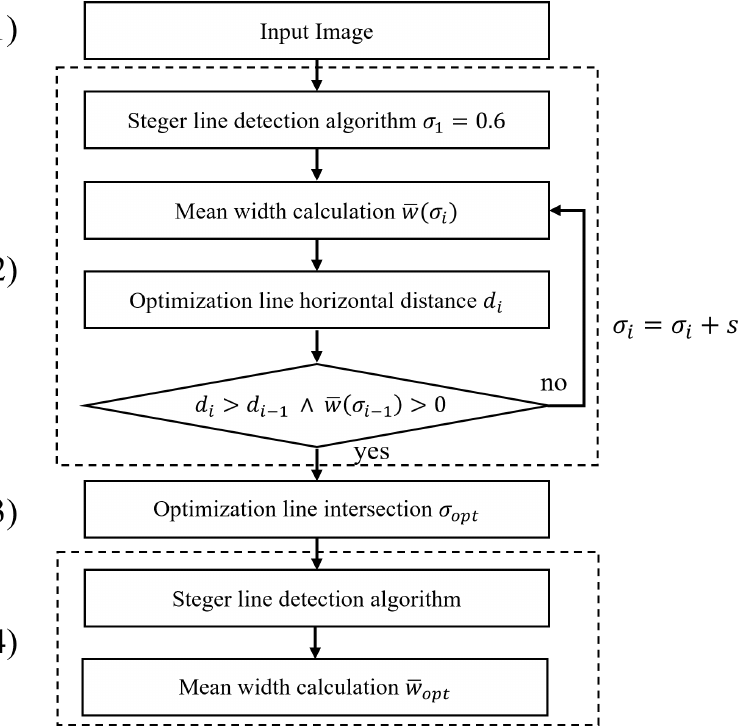
Figure 13. Proposed sigma optimization technique flowchart.